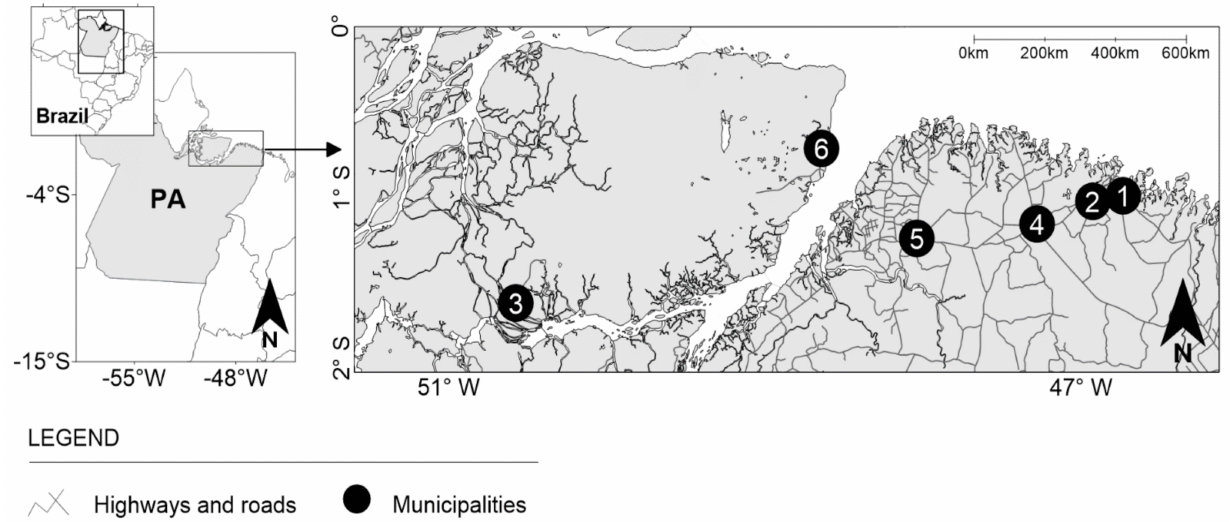
Figure 1. Geographical location of the six municipalities in the Brazilian state of Par á (PA) where the samples and personal data were collected from people who use crack-cocaine. Municipalities: ( 1 ) Augusto Correa, ( 2 ) Bragança, ( 3 ) Breves, ( 4 ) Capanema, ( 5 ) Castanhal and ( 6 )